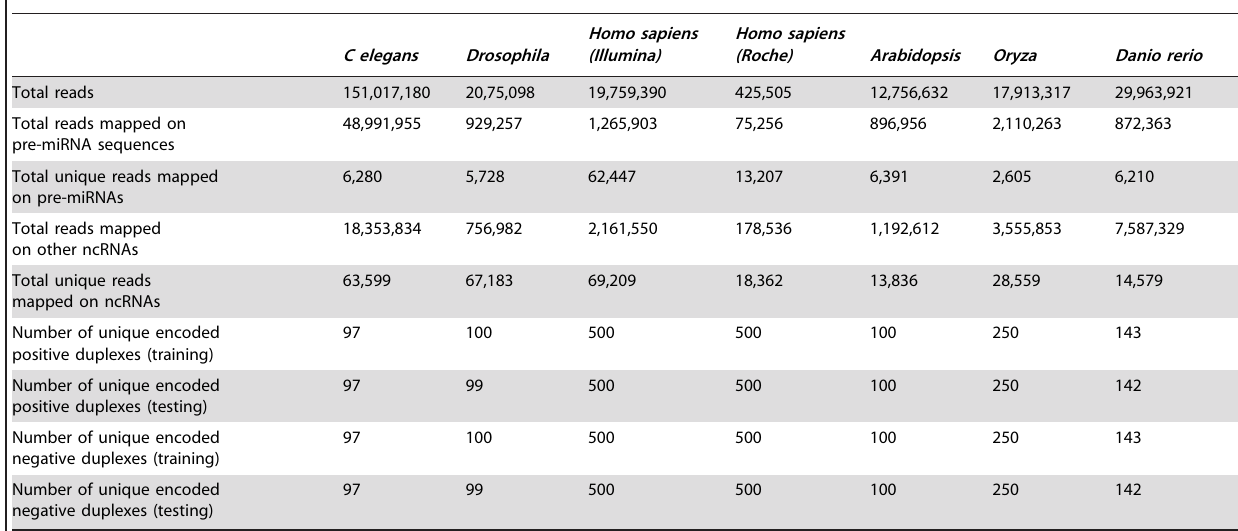
Table 1. Read data, training and testing set information for each